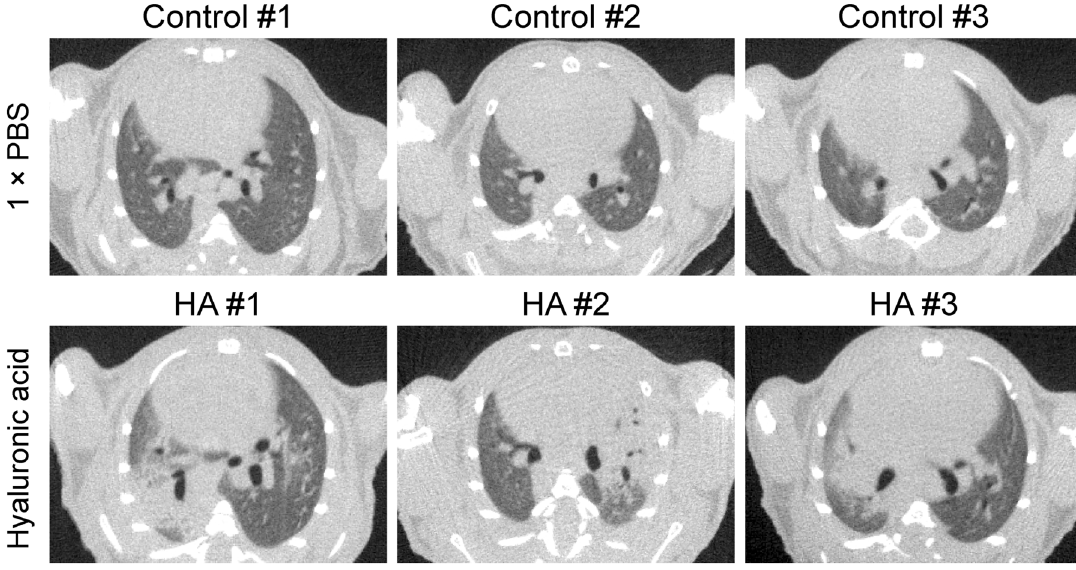
Fig. 4 Hyaluronan directly induces GGO and consolidation in adult mice. Represented CT images of lungs in mice with different treatments are shown. Adult C57BL/6 mice were used to assess whether hyaluronic acid induces pulmonary lesions. We directly delivered hyaluronan (200 – 400 kDa) to the trachea ( n = 3), and 1× PBS treatment was as the control group ( n = 3). Then, we monitored the lungs of mice in two groups via QuantumGX microCT at the fourth lymphopenia, CRP elevation, fi brinogen elevation, and D-dimer such, patients have better improvement of pulmonary lesions elevation, respectively. First, we reanalyzed the incidence of after hymecromone treatment. Thus, hymecromone could pro- lymphopenia, and the elevation of CRP, fi brinogen, and D-dimer in mote the pulmonary lesion absorption of COVID-19. these two groups using Fisher ’ s exact test (Supplementary Table Then, we calculated and compared the fold changes of these 1). There is no statistical difference of these events between the various clinical indicators per day in these two groups with